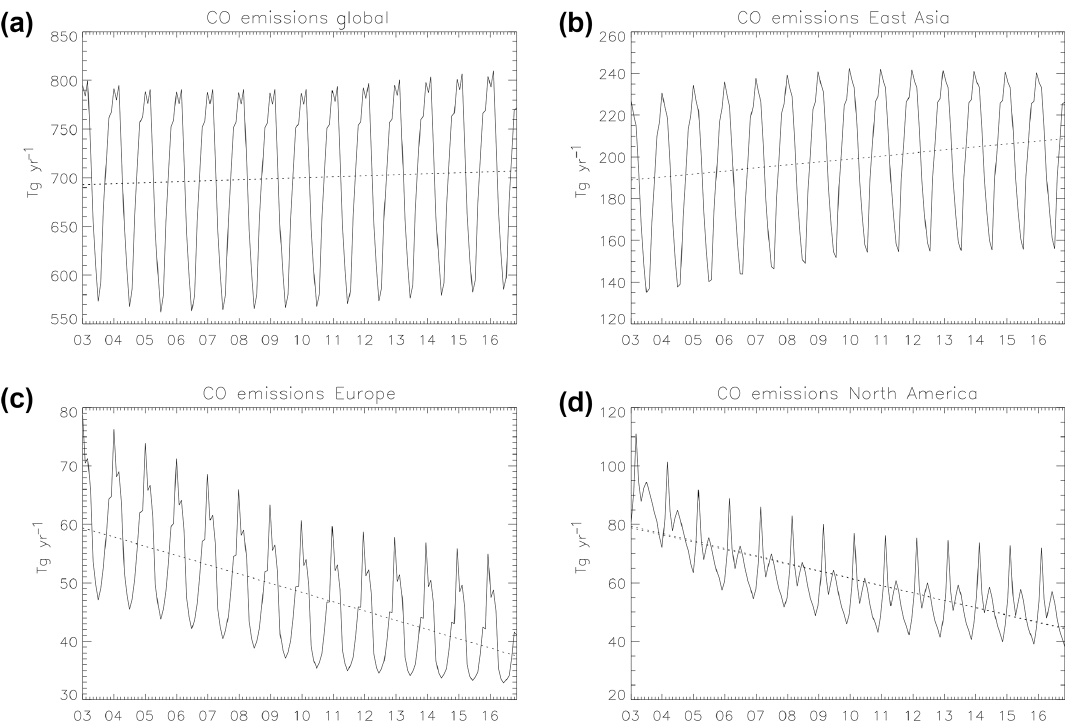
Figure 2. Monthly CO emissions in Tgyr − 1 from anthropogenic sources (MACCity with correction from Stein et al., 2014) for (a) the globe, (b) East Asia, (c) Europe and (d) North America for the period 2003–2016.